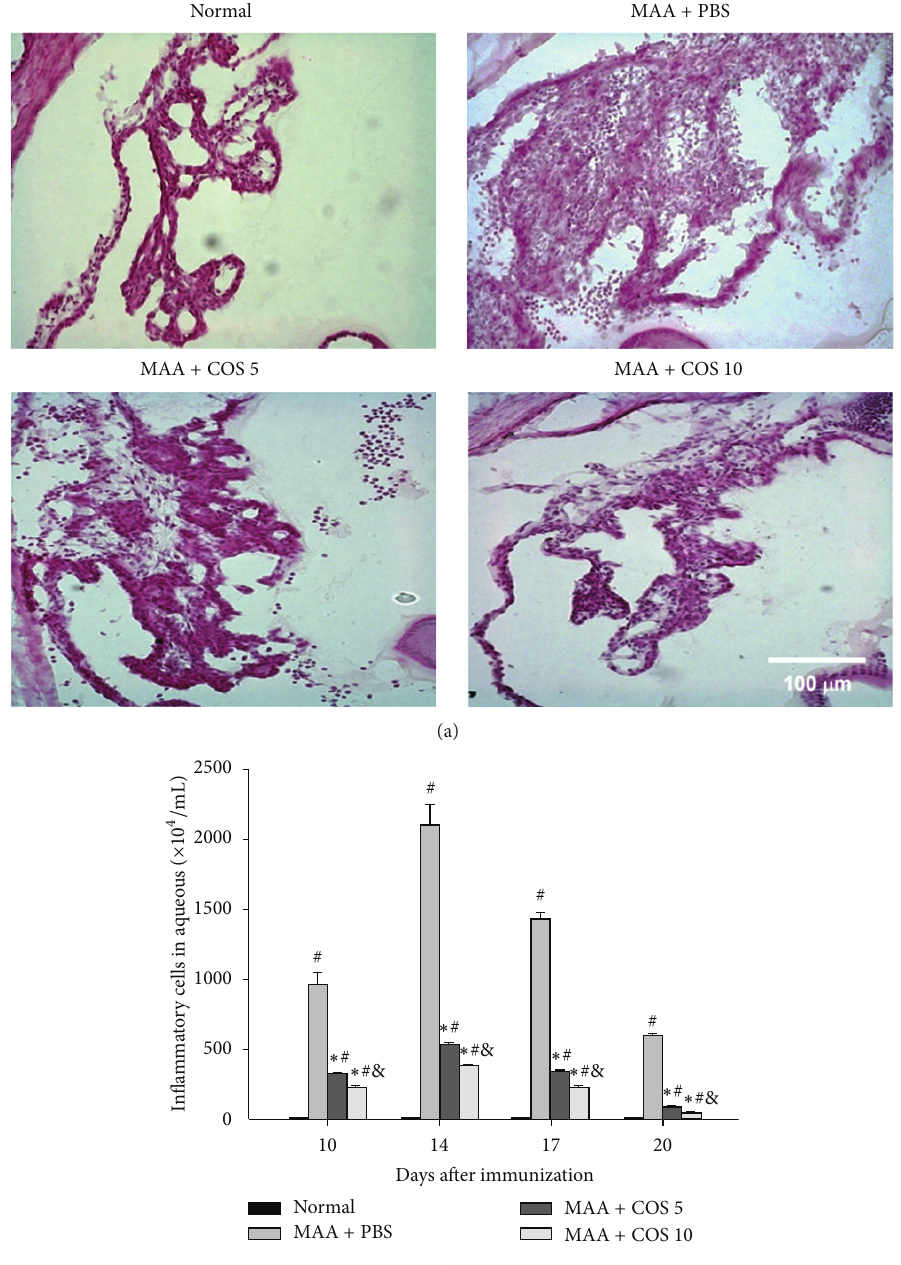
Figure 2: Effects of COS on histological changes in the iris/ciliary bodies (ICB) and leukocyte infiltration in the aqueous humor (AqH). (a) A representative H&E-stained ICB from normal or PBS-treated or high- or low-dose COS groups at day 14. The EAAU rats showed increased leukocyte infiltration in the ICB and the AqH, and the inflammation was attenuated by treatment with low-dose or high-dose COS. Original magnification 100x. (b) The quantification of leukocytes in the AqH at days 10, 14, 17, and 20. The EAAU rats treated with low-dose or high- dose COS showed significantly reduced leukocyte numbers in the AqH. The data are expressed as the mean ± SD ( ∗ 𝑃 < 0.05 compared with the PBS-treated group; # 𝑃 < 0.05 compared with the normal group; & 𝑃 < 0.05 compared with the low-dose group by Kruskal-Wallis 𝐻 test with post hoc Dunn test; 𝑛 = 3 for each